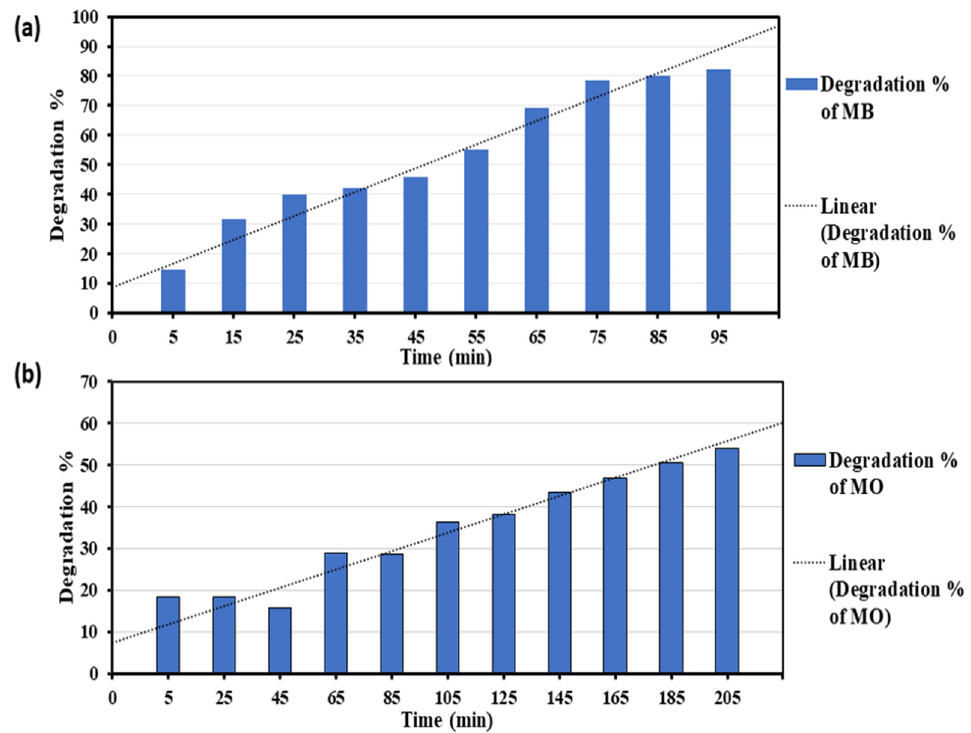
Figure 6. ( a ) Graphical representation of degradation of methylene blue and ( b ) Graphical represen- tation of degradation of methyl orange.